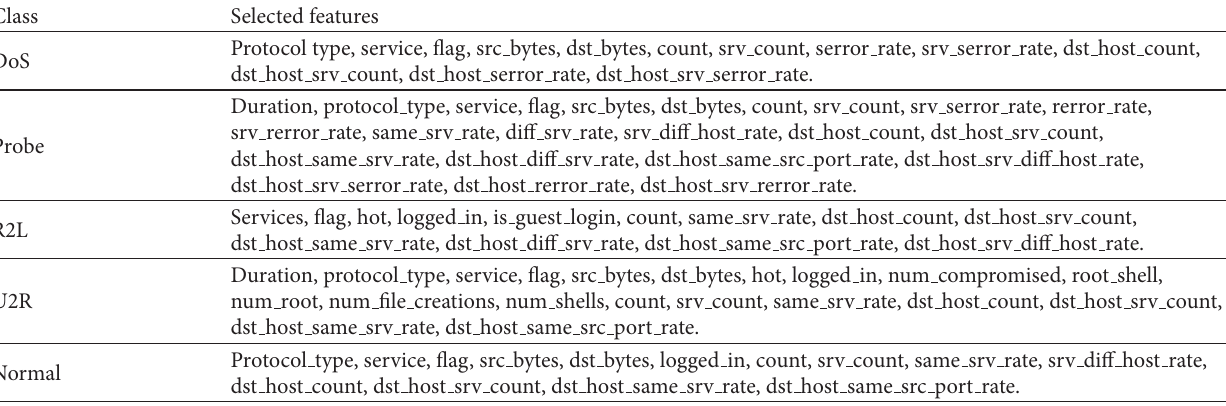
Table 3: Features selected for building MHT 2 S model.